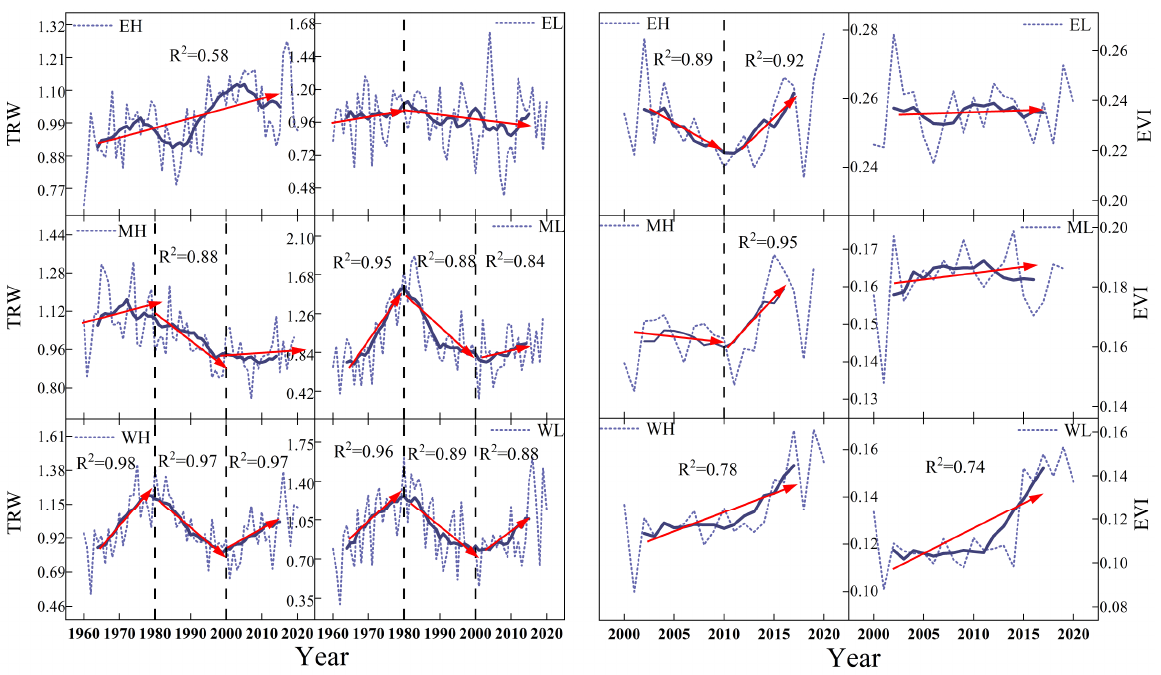
Figure 4. The trends of TRW from 1960 to 2020 and EVI from 2000 to 2020 (solid blue line—three-year sliding average, solid red line—linear regression).